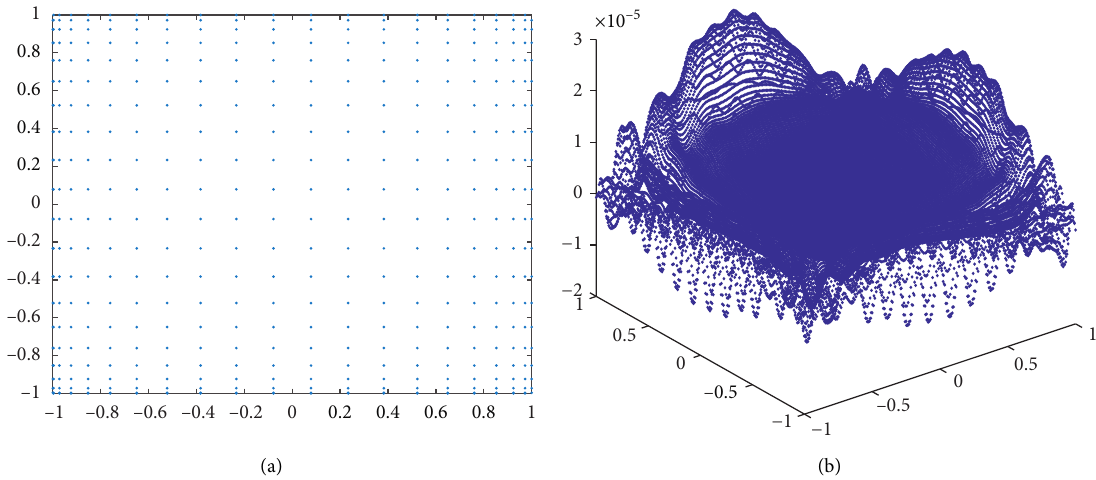
–1–0.8–0.6–0.4–0.201